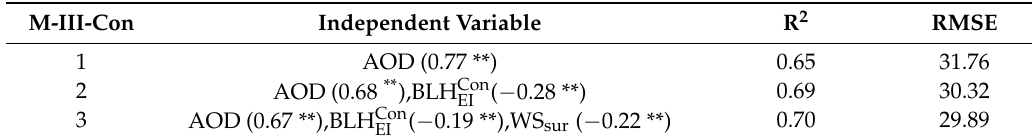
Table 4. Results of the stepwise regression of the M-III-Con (sample size n =